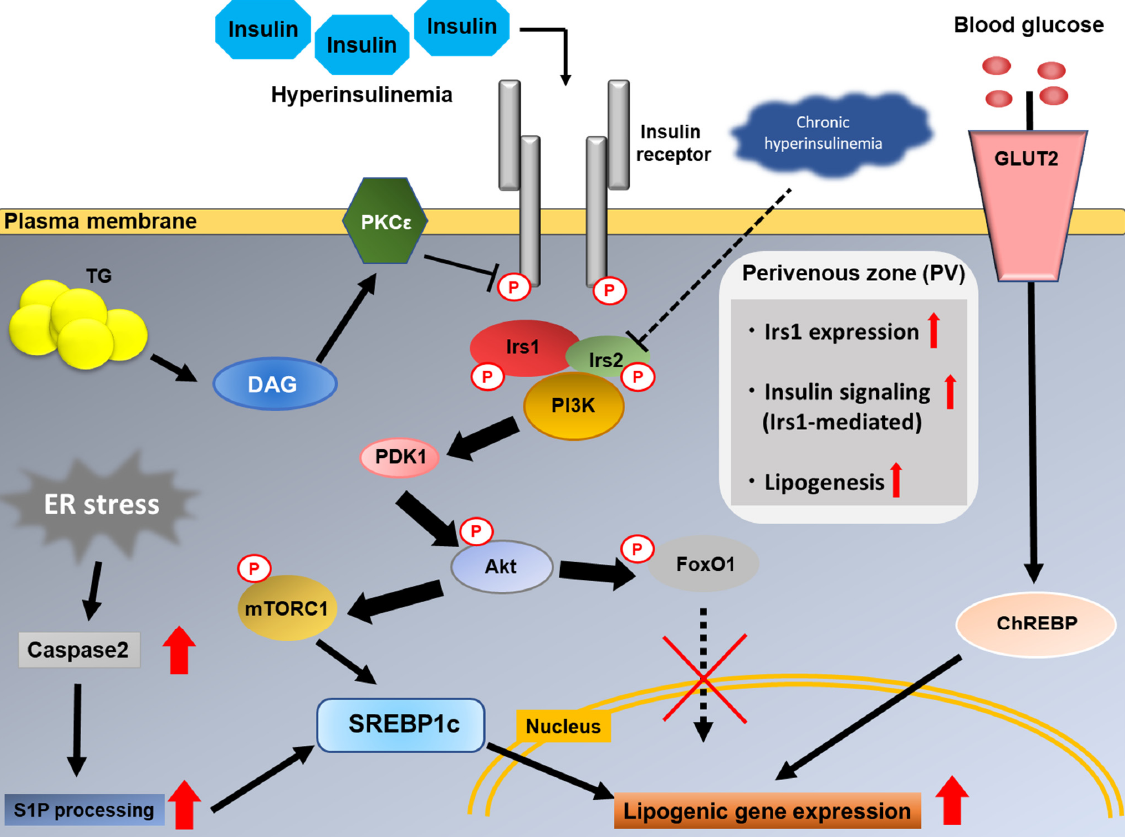
Figure 3. After insulin binds to the insulin receptor, autophosphorylation of tyrosine residues in the intracellular subunit of each of the receptors causes docking and phosphorylation of Irs1/Irs2, followed by activation of the downstream kinase cascades, such as the PI3K/Akt pathway. For induction of SREBP1c, mTORC1 activation and concomitant inhibition of FoxO1 via the PI3K/Akt pathway are required. In addition to the DAG-PKC ε pathway inhibiting physiological phosphorylation of the insulin receptor, hyperinsulinemia leads to downregulation of hepatic Irs2 expression, resulting in the progression of hepatic insulin resistance. GLUT2 is the major glucose transporter in hepatocytes. In response to an increase in the intracellular glucose concentration, ChREBP induces expression of various genes related to lipogenic enzymes, independent of insulin signaling. Due to elevated Irs1 expression in the perivenous (PV) zone, which is the primary site of lipogenesis, insulin signaling is rather enhanced in the presence of hyperinsulinemia despite the downregulation of Irs2, resulting in increased lipogenesis and development of steatosis. Independent of insulin signaling, ER stress also activates SREBP through increased cleavage of S1P by